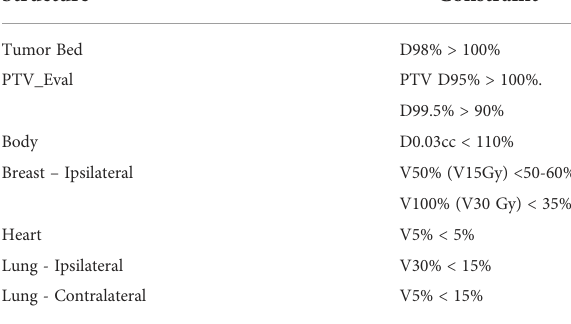
TABLE 3 Dose constraints for our APBI